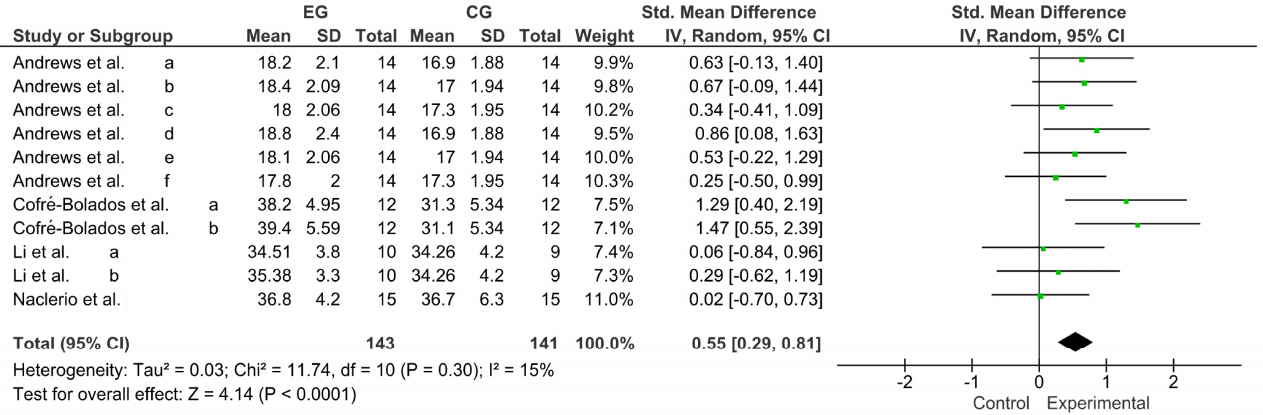
Figure 7. Forest plot comparing the effects of training with VR on jump height [28,29,34,39].